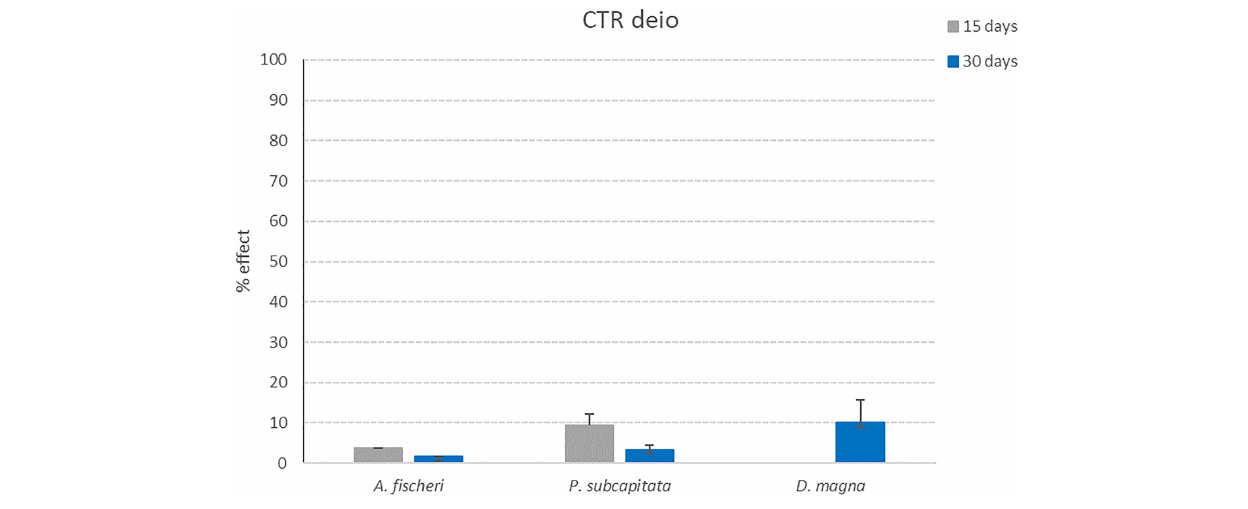
Frontiers in Marine Science |